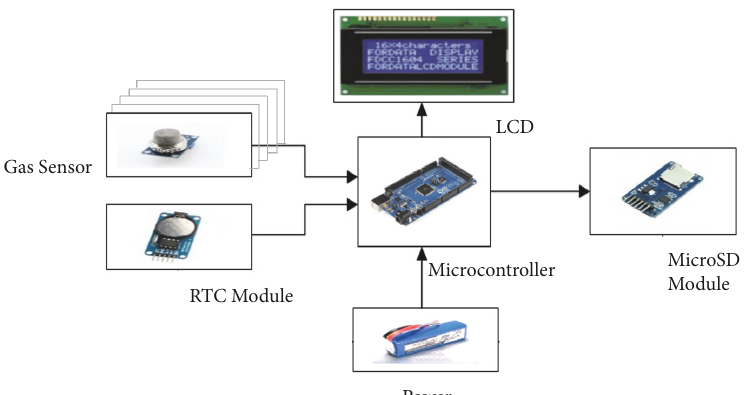
Figure 1: Work system diagram of mobile emission